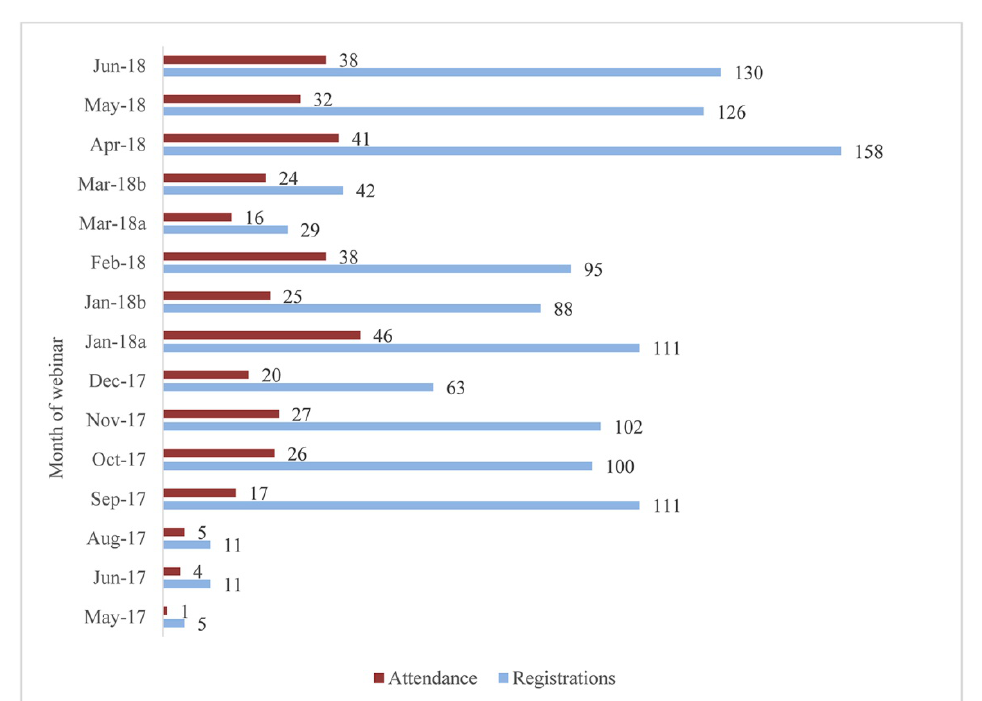
Figure 1 Number of registrations and attendees per webinar